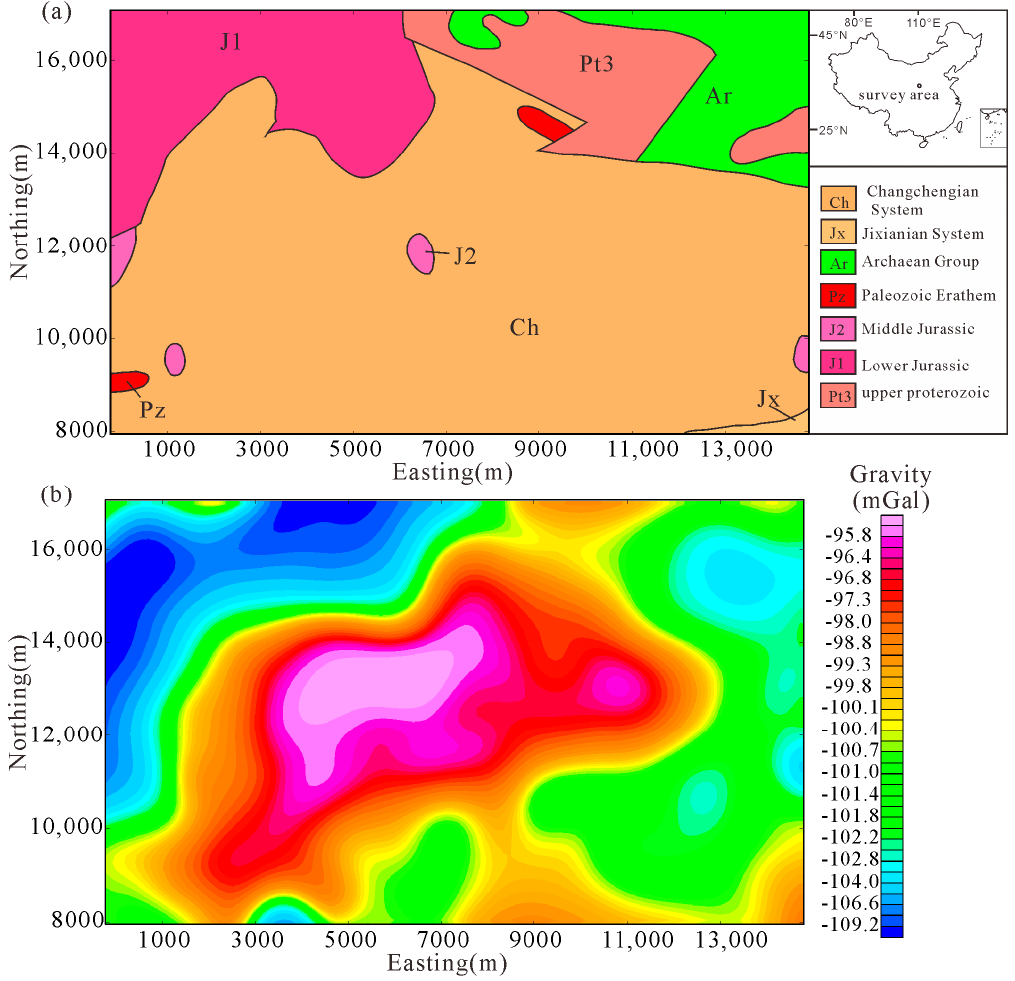
Figure 6. Geological and gravity of survey area. ( a ) The geological map; ( b ) Bouguer gravity anomaly.